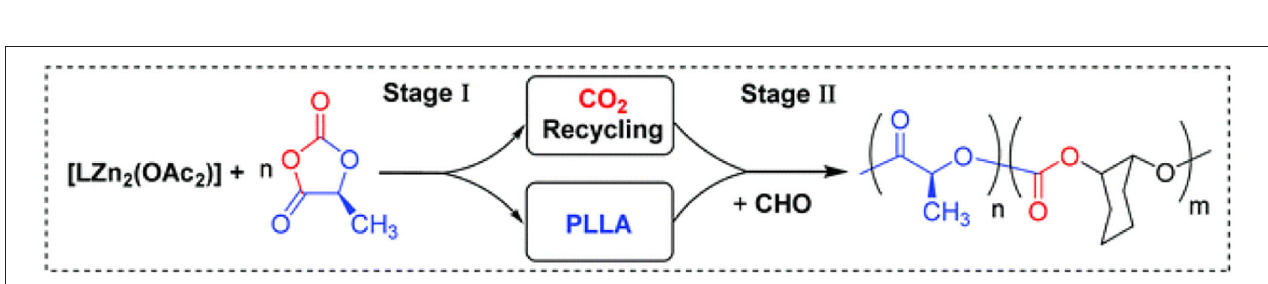
FIGURE 3 | Polyesters and block copolymers based on the bio-derived anhydride, BCA1, were produced using catalysts LZn 2 (OAc) 2 ( 1a ) and LMg 2 (OAc) 2 ( 1c ). The images are reproduced from Saini et al. (2017).